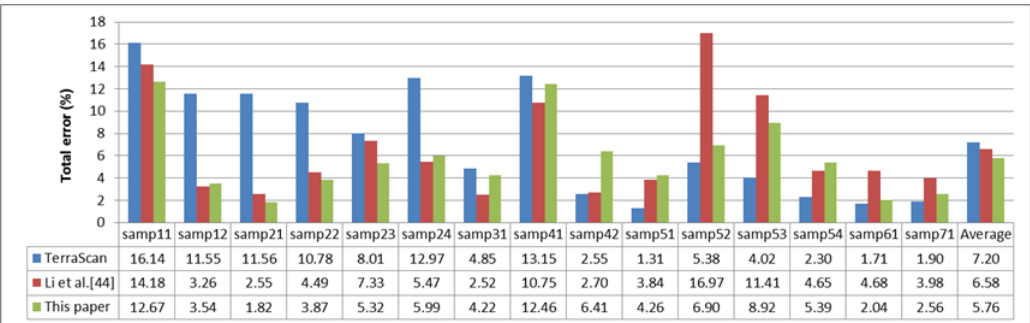
Figure 9. Comparison of total errors for filtering ISPRS datasets.